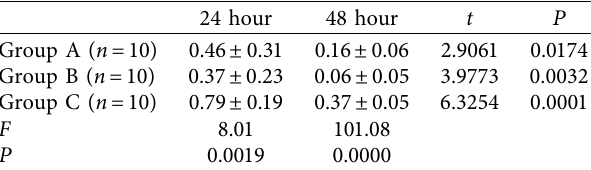
Table 2: The RNA levels of hypoxia